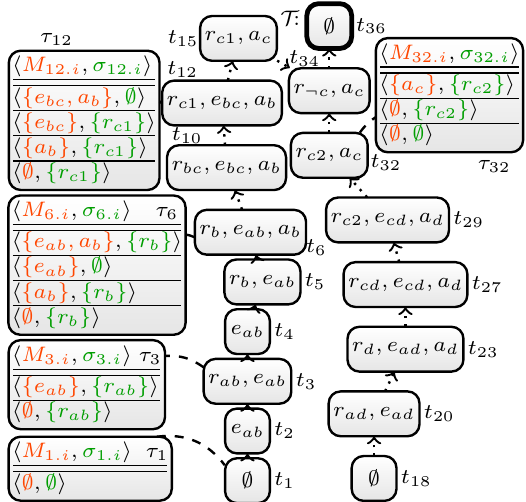
Figure 2. The tree decomposition T of the semi-incidence graph S ( P ) for program P from Example 1 and Figure 1. Selected DP tables after DP MOD . We explain details of the figure in Example